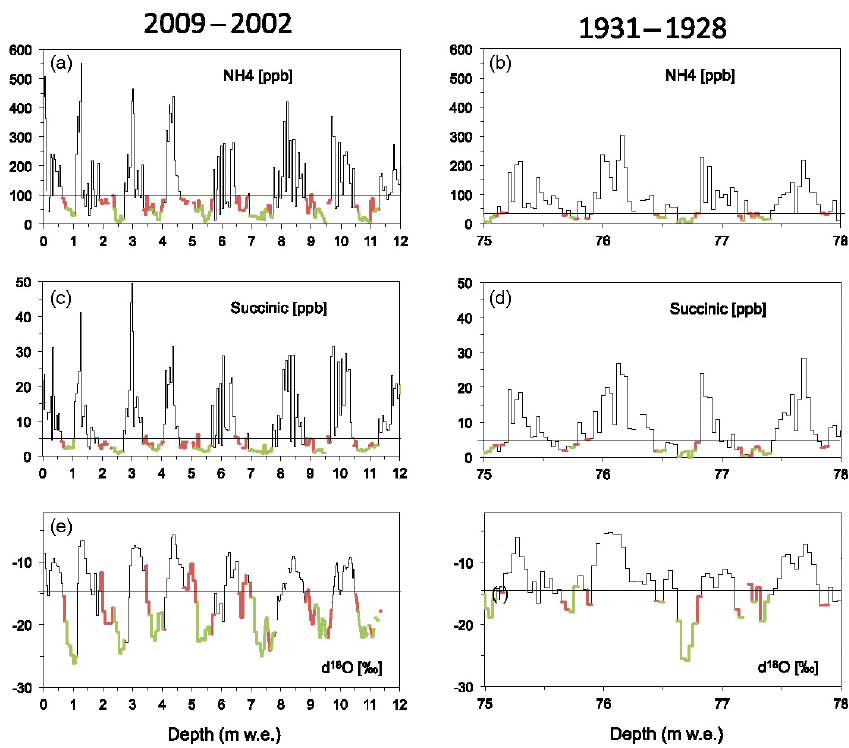
Figure 8. Seasonal variations in NH + (a, b) , succinic acid (c, d) , and δ 18 O (e, f) for different sections of the Elbrus ice core. Red sections 4 demonstrate winter samples based on the following criteria: succinic acid less than 5ppb, NH + than 50ppb prior to 1950. Green sections meet the following winter-background criterion: succinic acid less than 3ppb, NH + 50ppb for recent years, and less than 20ppb prior to 1950. Black bars in ionic plots refer to the winter criteria. The black bars in the δ 18 O plots refer to the respective mean